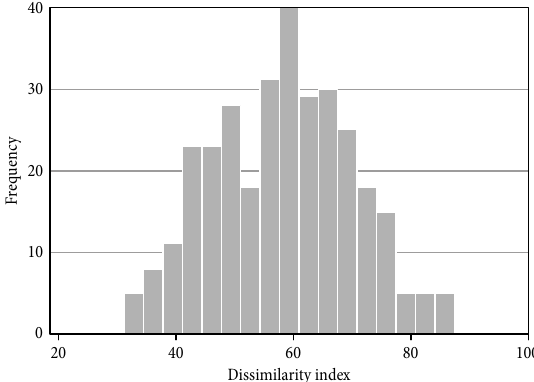
Fig. 1. American metropolitan areas dissimilarity index